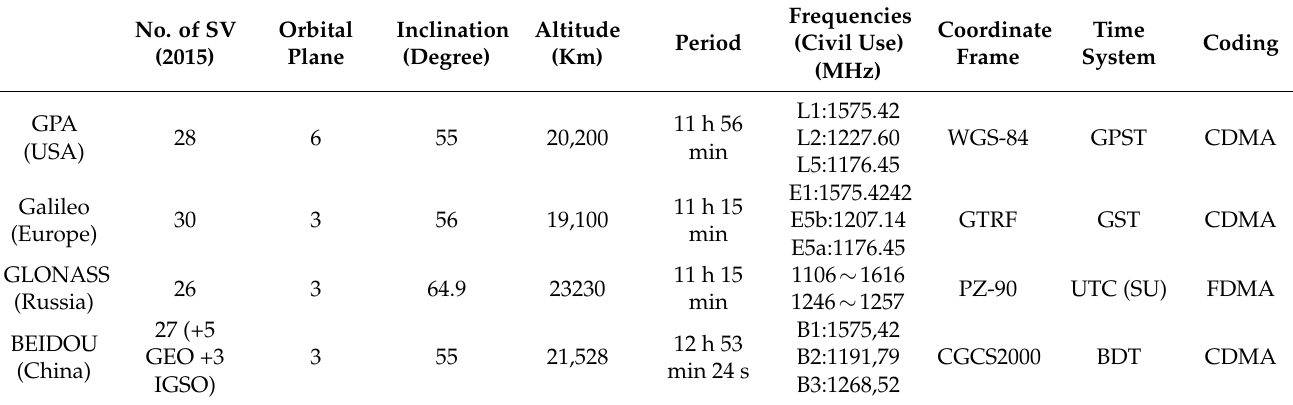
Table 6. Basic information on GSSN constellations, Space Vehicle (SV) number, altitude platform, period of movement, frequency used, and most principles of the navigation